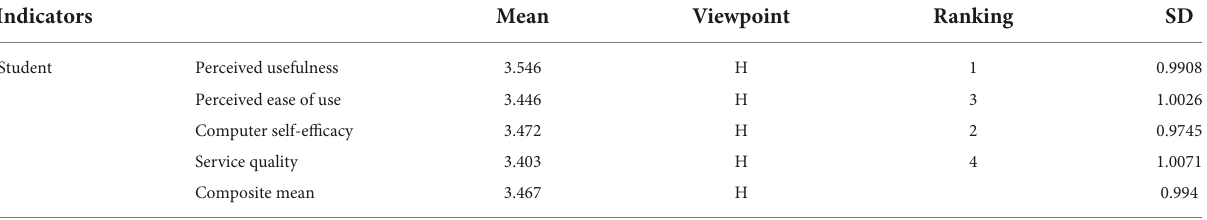
TABLE 1 Level of the factors influencing blended learning at a computer science college.